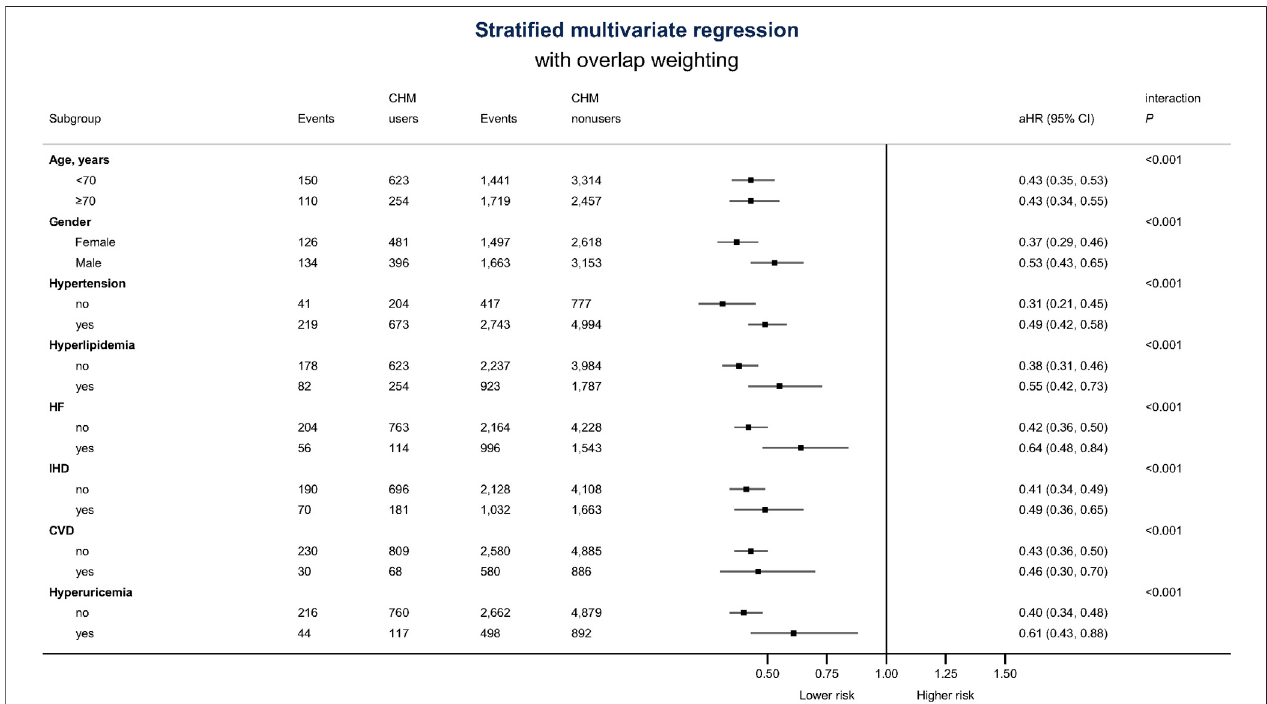
FIGURE 4 | Forest plot of strati fi ed multivariate